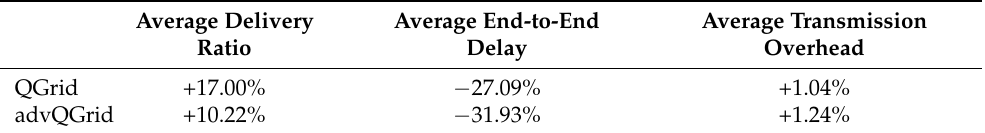
Table 9. Performance improvement of SD-QGrid compared to routing protocols with